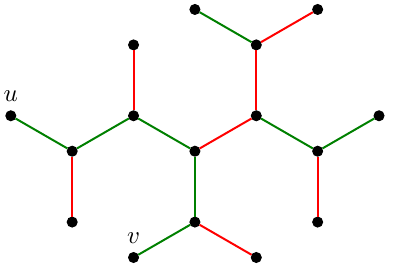
Fig. 11: A partition of the edges of the tree T in Lemma 14. The paths in A T those in B T are colored u,v